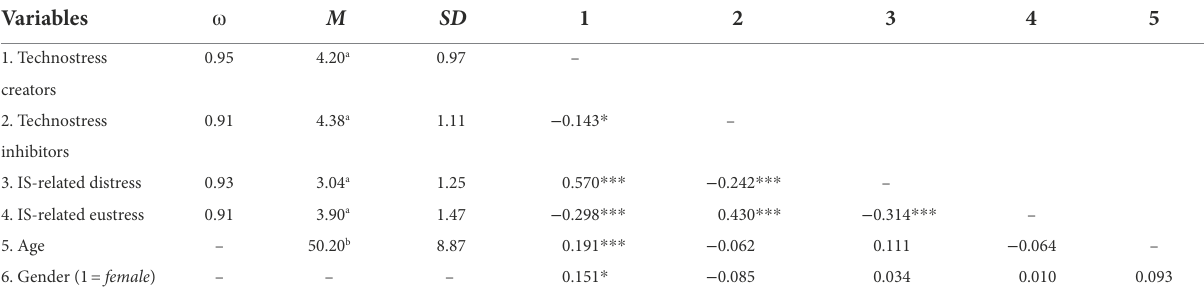
TABLE 1 Summary of reliability indices, descriptive statistics, and